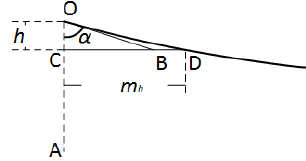
Figure 6. Calculation of the elevation difference of each layer.